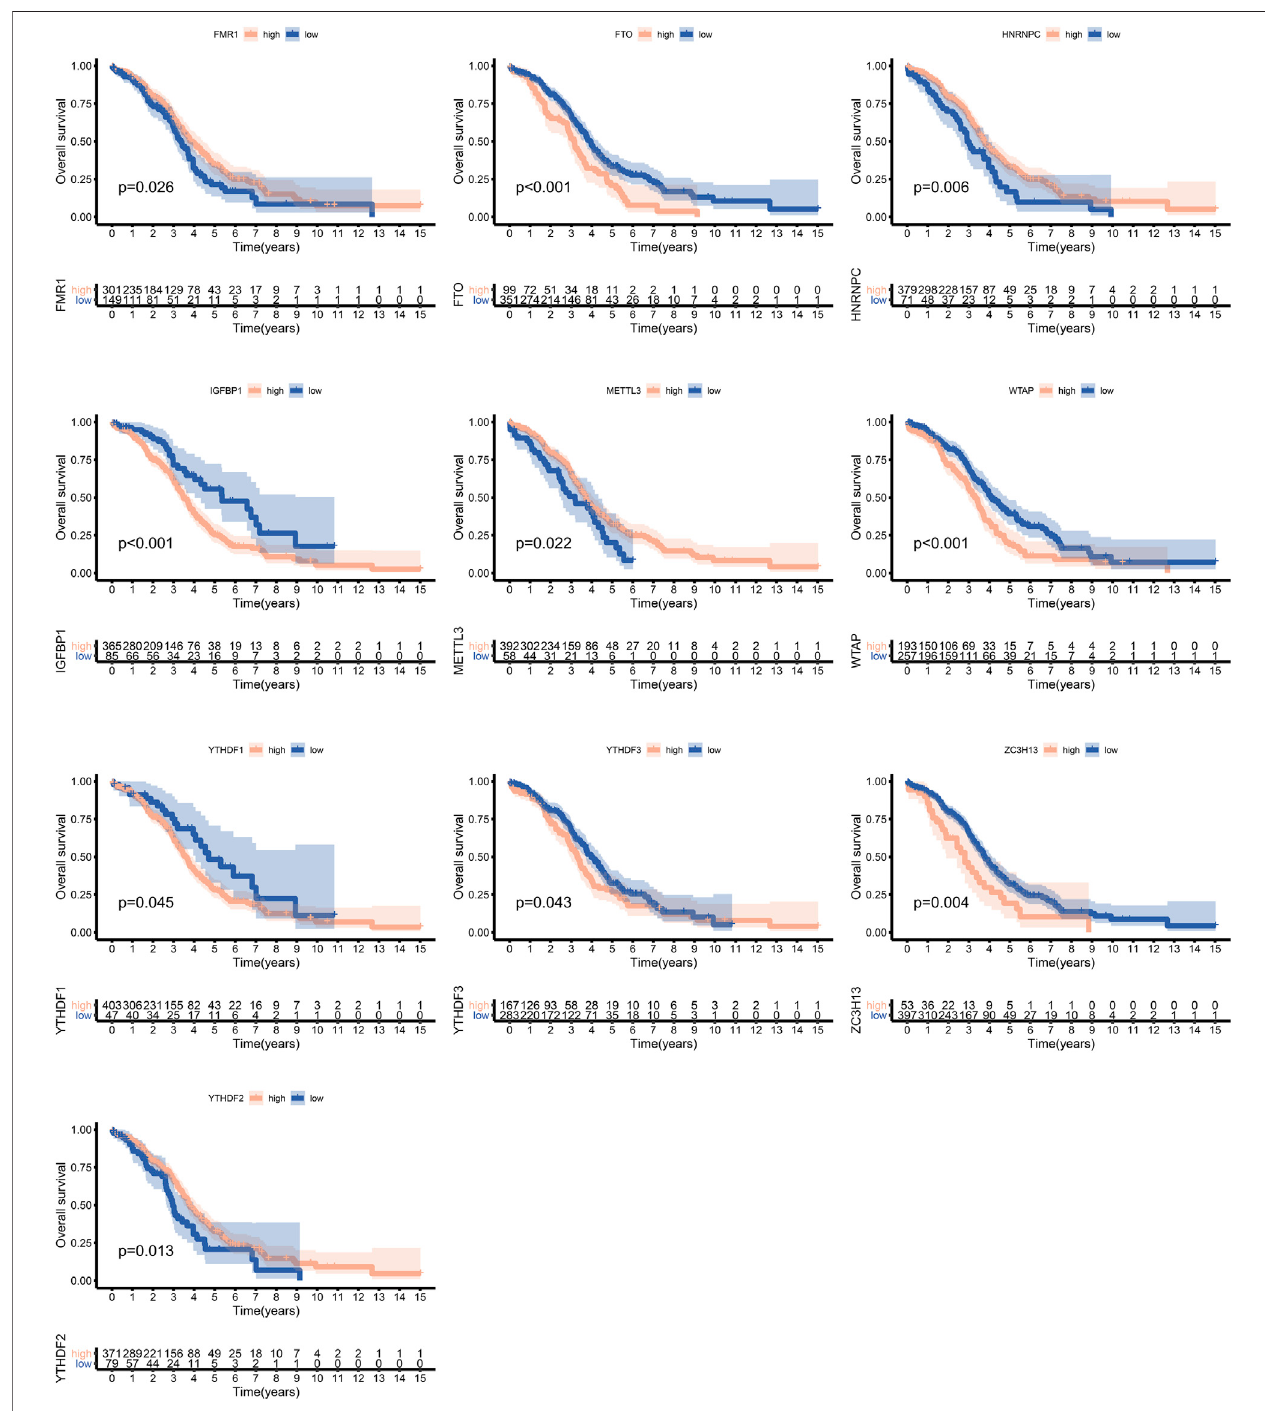
FIGURE 2 | Survival analysis of m6A regulators in ovarian cancer according to TCGA and GSE14764 cohorts.